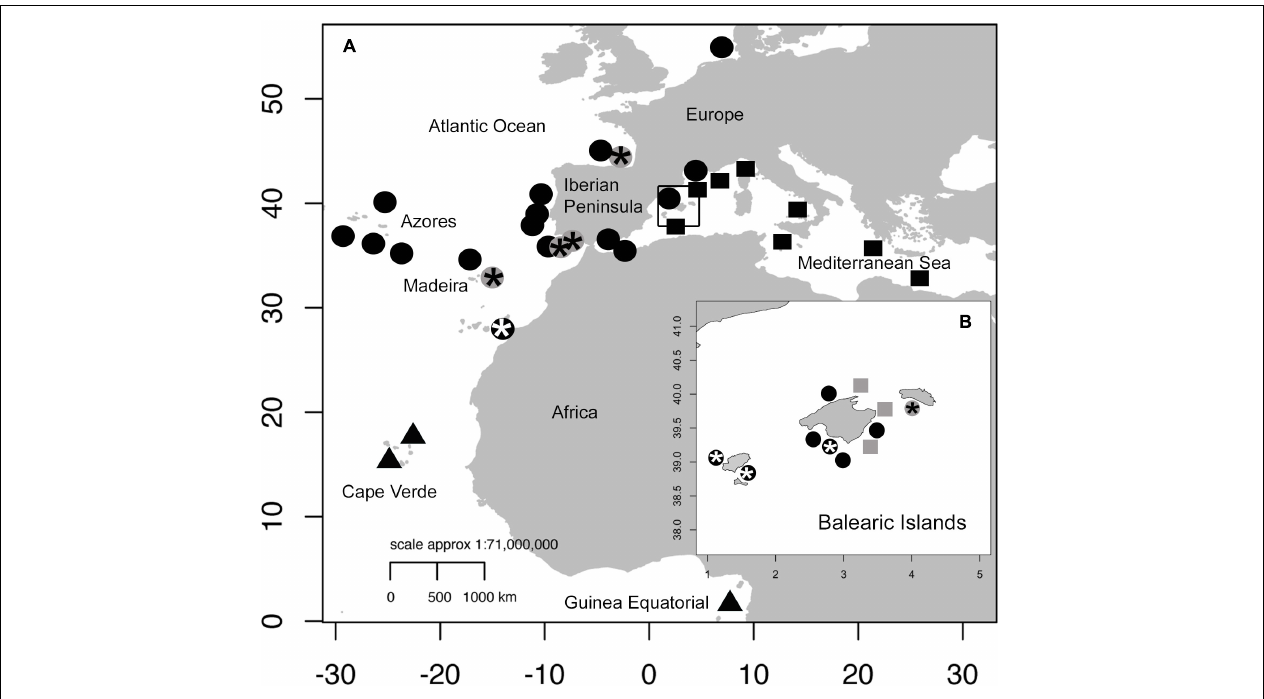
FIGURE 1 | Map of Atlantic and Mediterranean sampling locations for Coris species. (A) Coris samples at each location for morphological (Laurent and Lejeune, 1988; Zabala et al., 2005; Martino and Grau, 2010) and molecular studies (Guillemaud et al., 2000; Aurelle et al., 2003; Arnal et al., 2006; Kazancioglu et al., 2009; Matschiner et al., 2011; Landi et al., 2014; BOLD Systems sequences) are indicated as follows: Coris atlantica in triangles; C. melanura in circles and C. julis in squares. (B) Coris specimens reported from Balearic Islands are shown. The Coris specimens collected in the present study for molecular and morphological analyses from Madeira, Portugal, Cantabria Sea, Gulf of Cadiz and Balearic Islands are indicated in gray, and those specimens used only for morphological analysis are indicated in